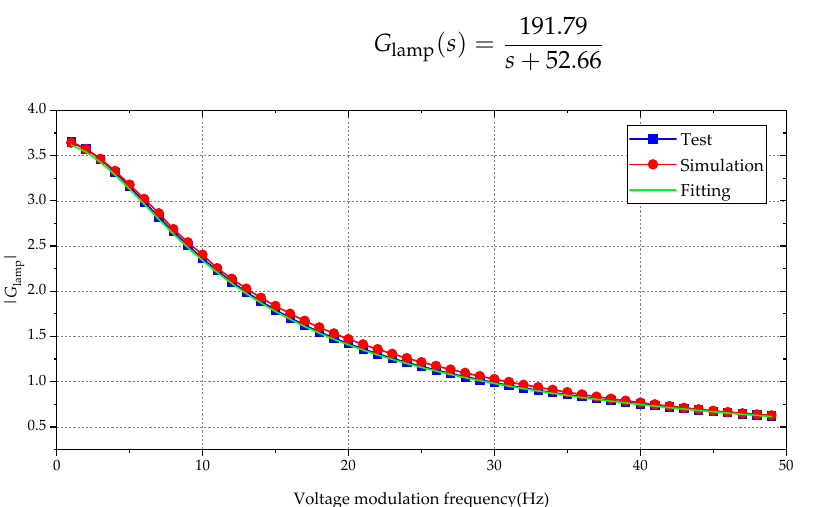
Figure 4. Response of the 60 W incandescent lamp at 230 V/50 Hz under different voltage modulation frequencies.